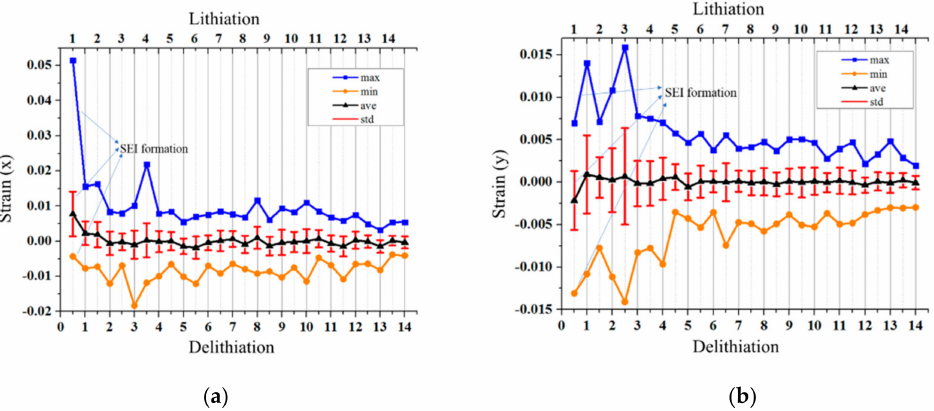
Figure 6. ( a ) Evolution of strains along x direction in electrochemical cycles, and ( b ) evolution of strains along y direction in electrochemical cycles.